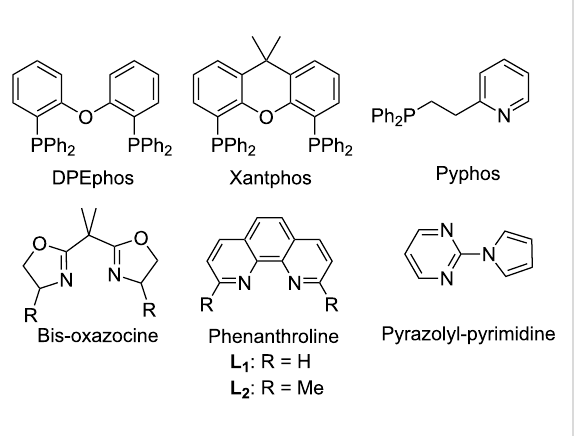
Figure 1: Bi-/tridentate ligands used for the optimization of the reac- tion conditions.